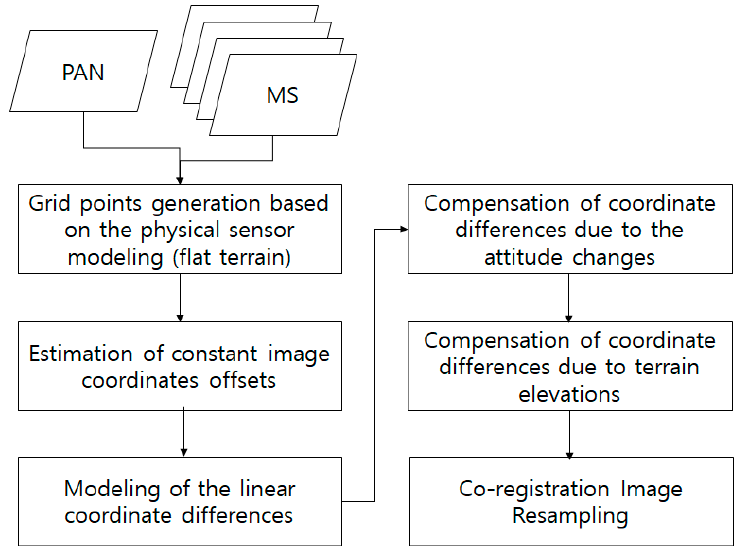
Figure 3. Flowchart of rigorous multispectral (MS) and panchromatic (PAN) image co-registration in this study.